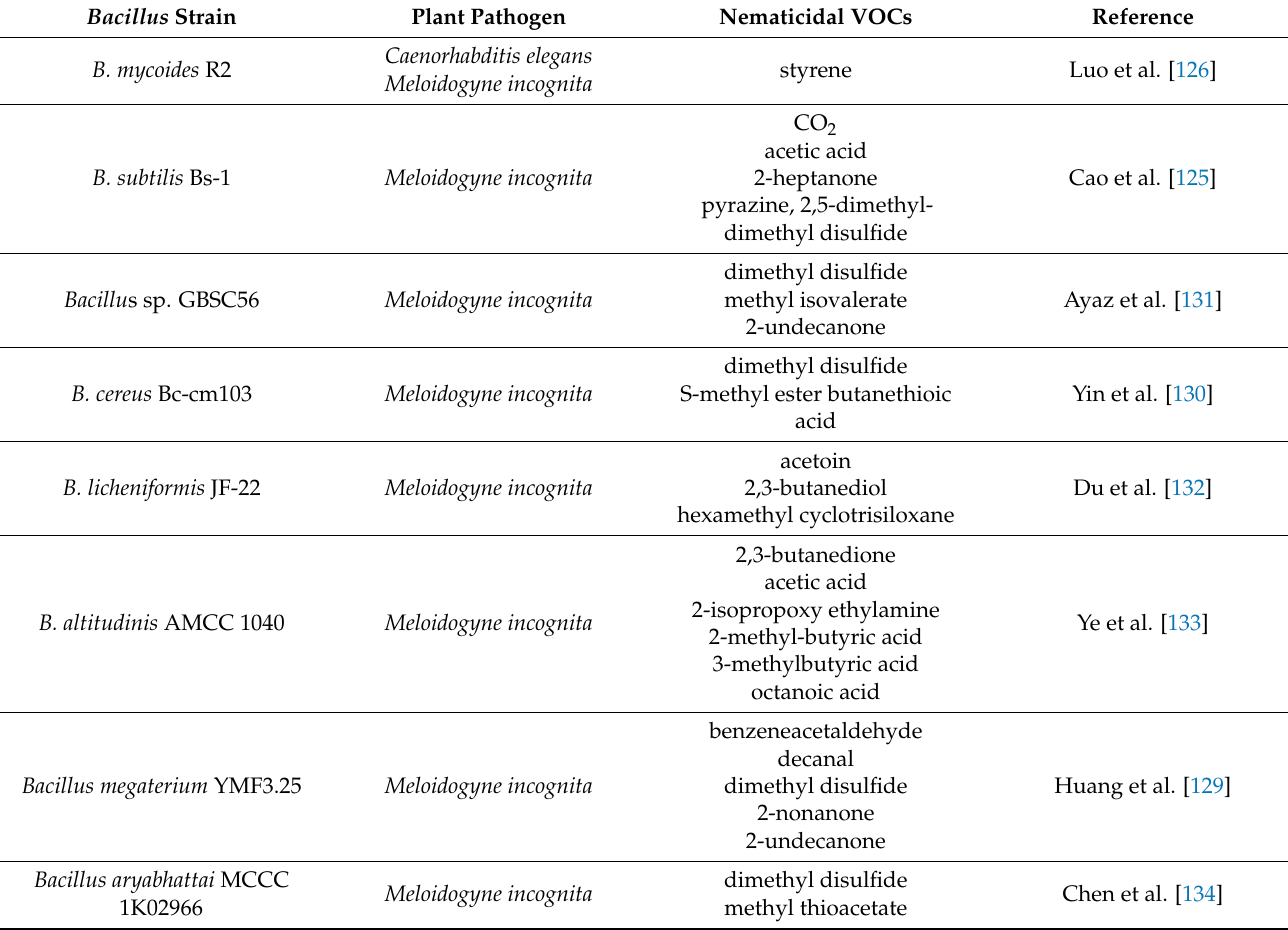
Table 3. Literature overview—nematicidal VOCs produced by Bacillus